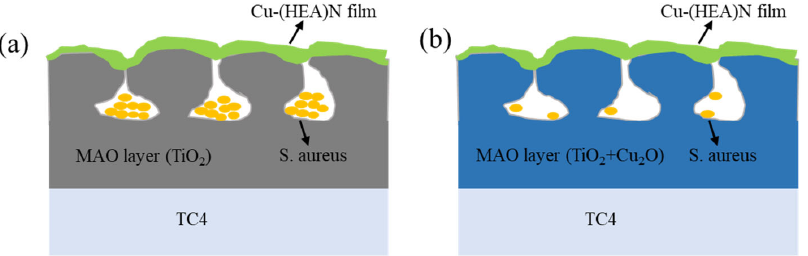
Figure 10. Mechanism of the effect of CuSO 4 on the antibacterial ability of MAO ‐ Cu/Cu ‐ (HEA)N composite coating: ( a ) without CuSO 4 ; and ( b ) with CuSO 4 .